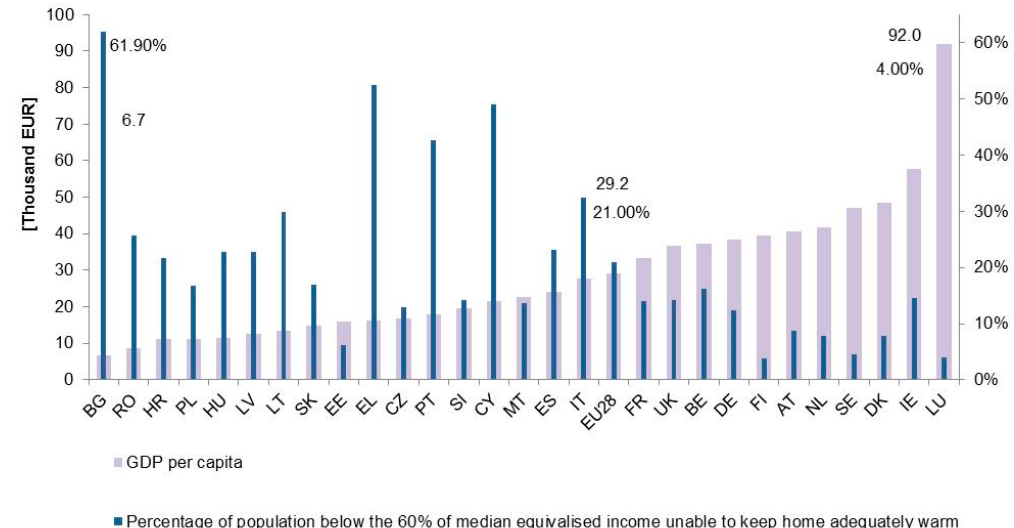
Figure 7. Gross domestic product per capita at current market prices in the EU-28, 2000–2016. Source: Eurostat.